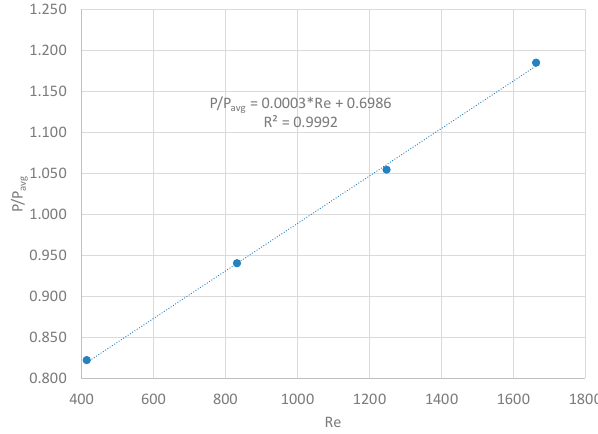
Figure 20. Effect of inlet mass flow rate on windage losses for P avg = 191.5 W.